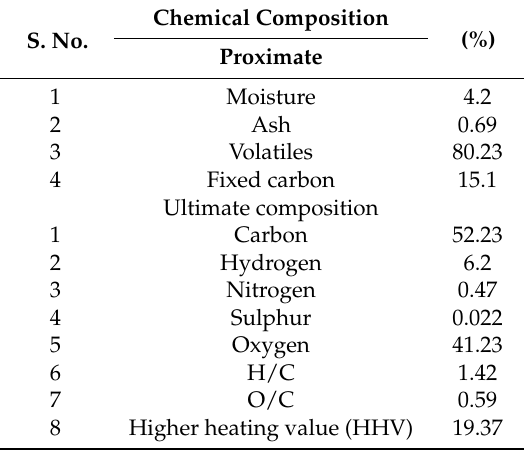
Table 3. Proximate, ultimate, and higher heating values of the 2-mm lodgepole pine grind.